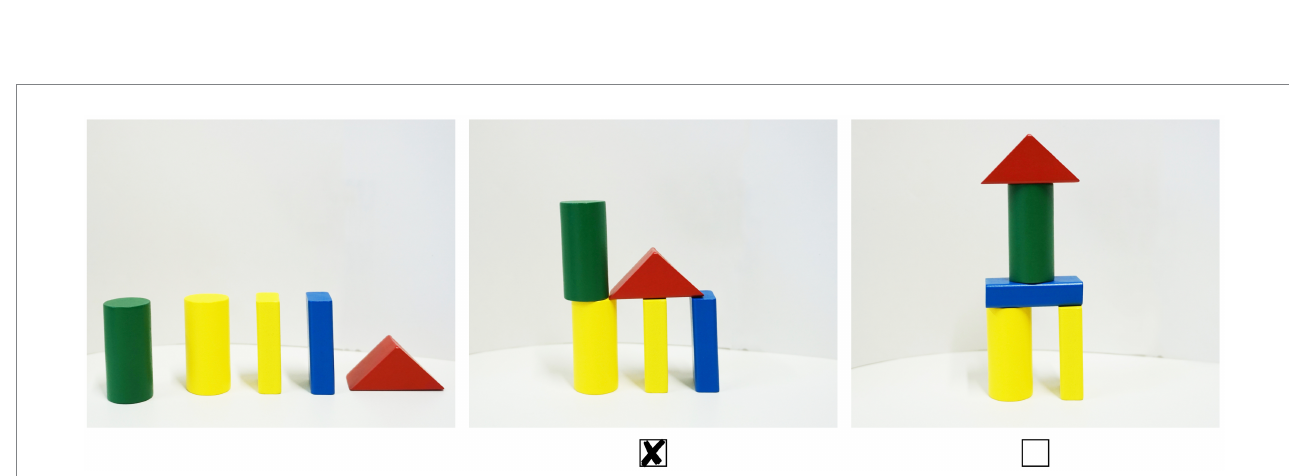
FIGURE 3 Multiple choice test: The correct spatial arrangement of the building blocks according to the rules had to be marked.